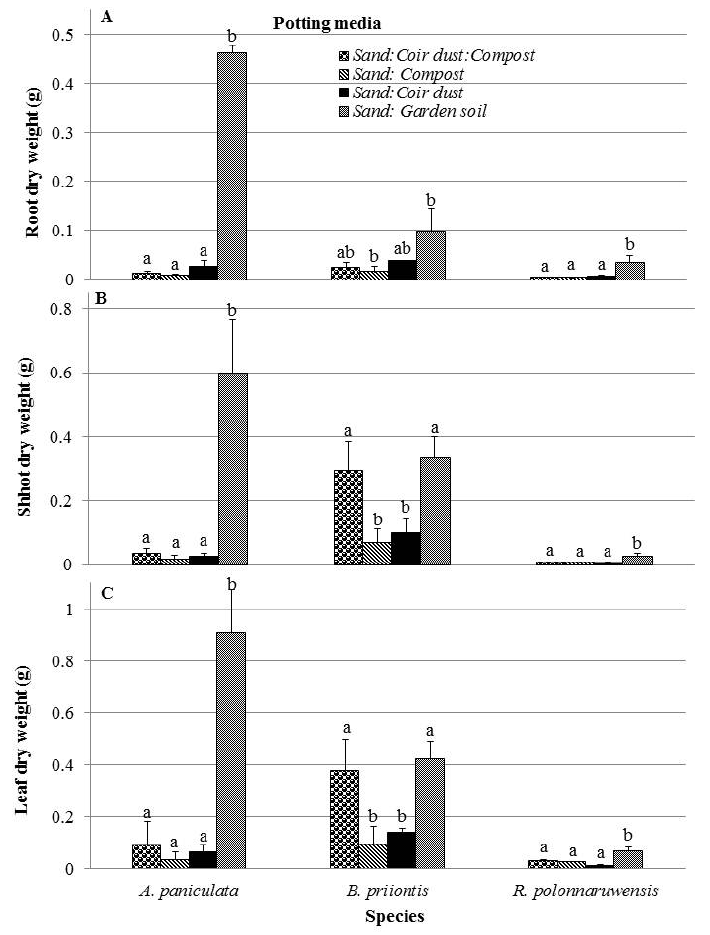
Figure 4: Root (A), shoot (B), and leaves (C) dry weight of A. paniculata var. paniculata, B. prionitis and R. polonnaruwensis seedlings grown in different potting media for 30 days. One-way ANOVA, error bars + SD, n = 10. Different lowercase letters indicate significant differences among treatments within the same species (P <